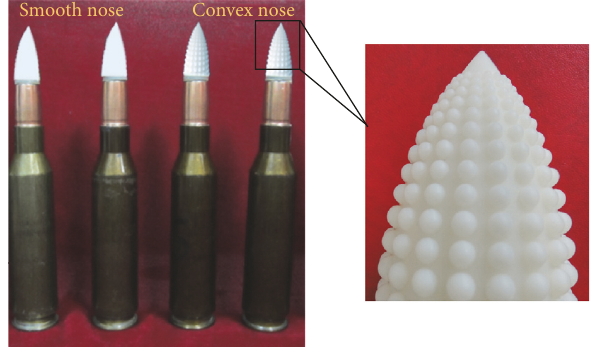
Figure 17: Experimental projectiles.